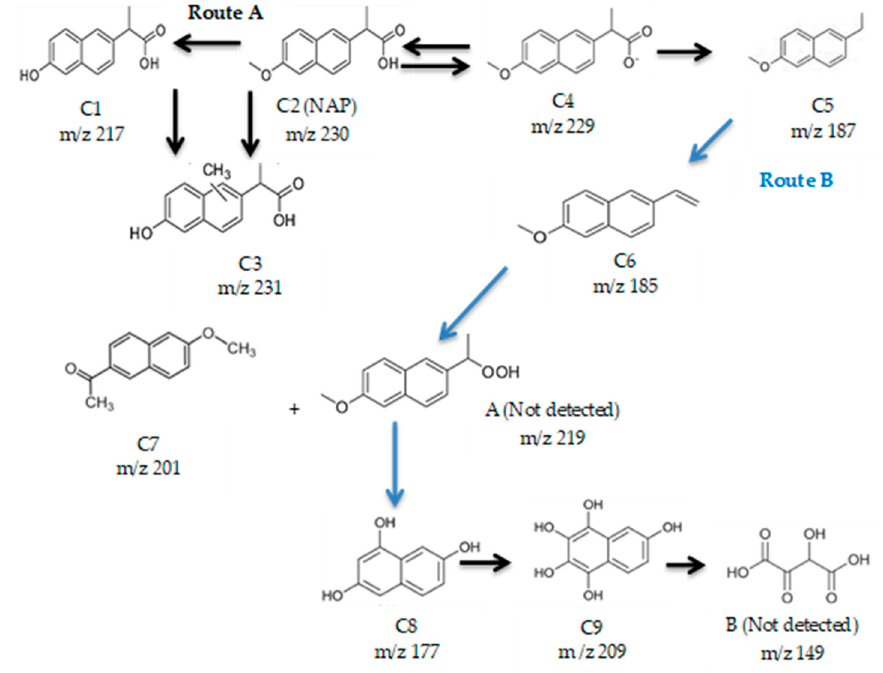
Figure 9. Proposed reaction pathways for the degradation of NAP by CWPO.